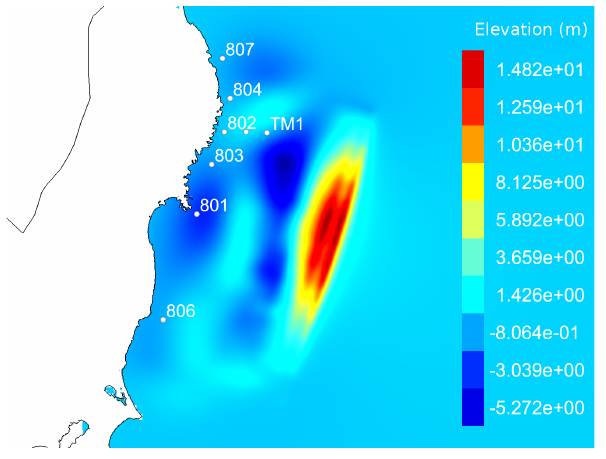
Fig. 5. Initial vertical displacement (metres) derived from the sub- faults model of Shao, Li and Ji, UCSB (Preliminary model III). The location of wave buoys (801–807) and bottom pressure gauges records (TM1 and TM2 located between TM1 and 802) used in this study are also